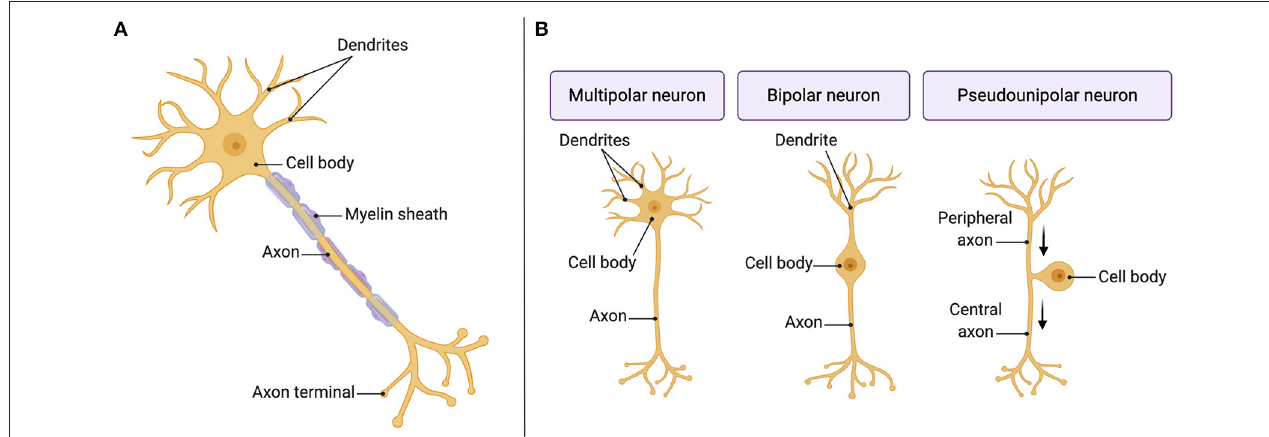
FIGURE 1 | The neuron: the primary cell in the nervous system. (A) Structural parts of a neuron. (B) Different structural classes of